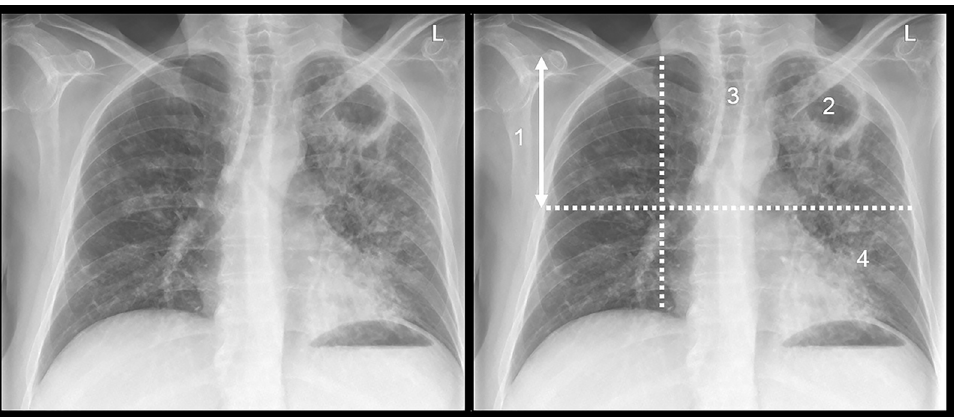
doi:10.1371/journal.pone.0154032.g001